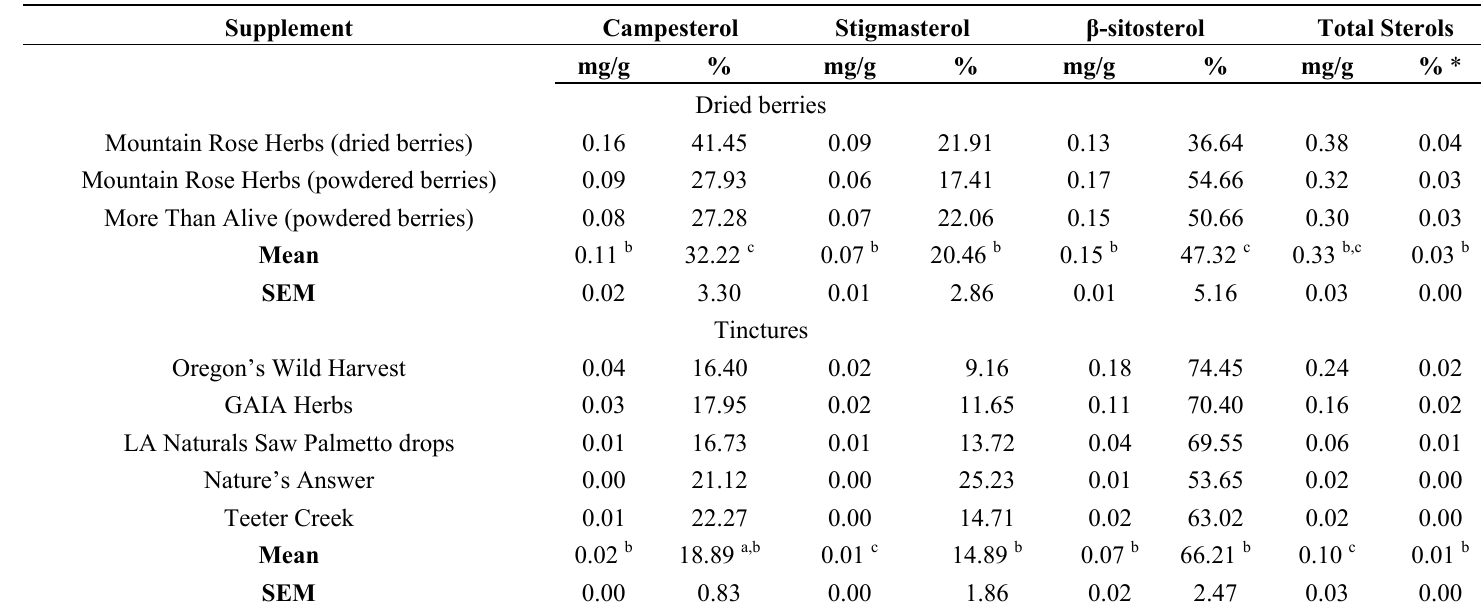
Table 5. Phytosterol quantities (mg/g) and composition (% of total phytosterols) in dried berry and tincture saw palmetto supplements.